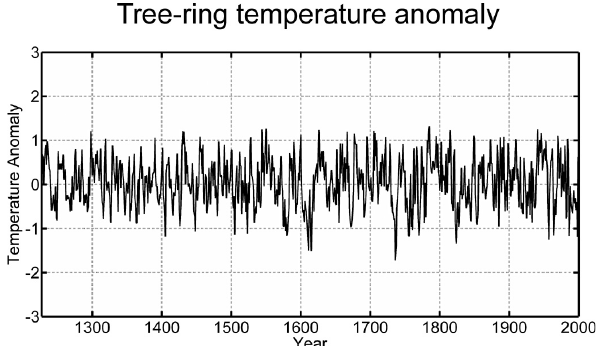
Fig. 5. Tree-ring temperature variability time series from the West- ern